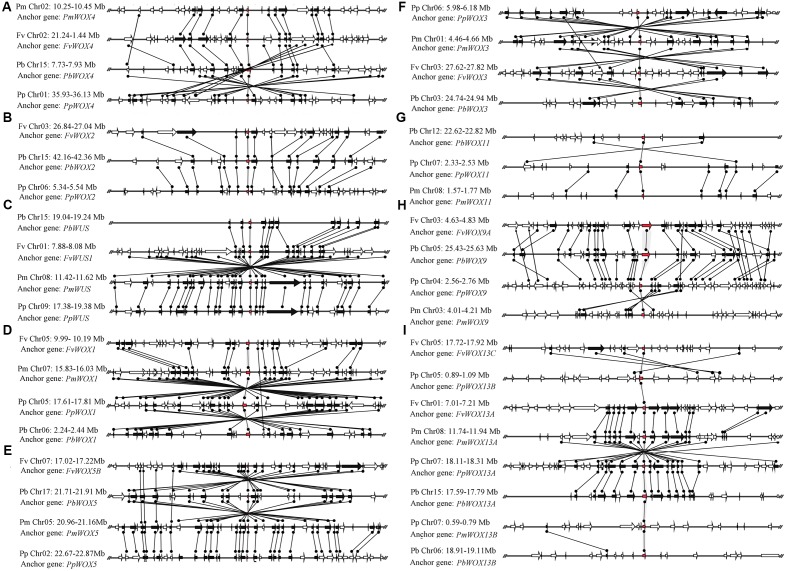
Extensive microsynteny of WOX regions across P. bretschneideri (Pb), P. persica (Pp), F. vesca (Fv), and P. mume (Fm) chromosomes. The gene’s orientation on strands was indicated by the triangle. Remarkably, the relative positions of all flanking protein-coding genes were defined by anchored WOX genes, highlighted in red. Subsequently, we used black lines to connect the homologous genes on two fragments. All genes are numbered from left to right, in order, for each segment. The (A–I) subfamilies in figure were consistent with those in Figure 2.